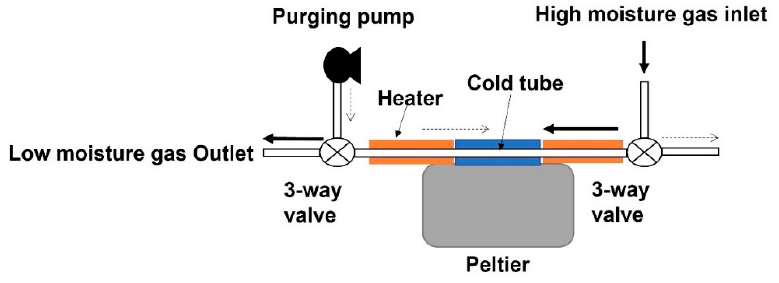
Figure 1. Schematic of KPASS–Odor.